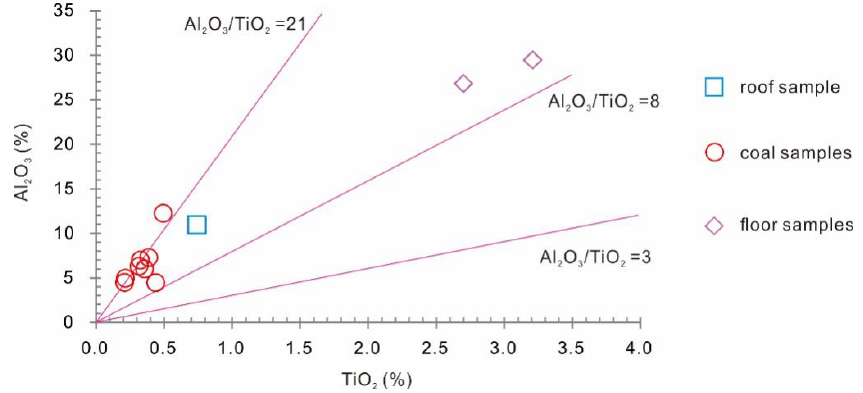
Figure 9. Relationships between Al 2 O 3 and TiO 2 of coal seam in the Donggou mine.